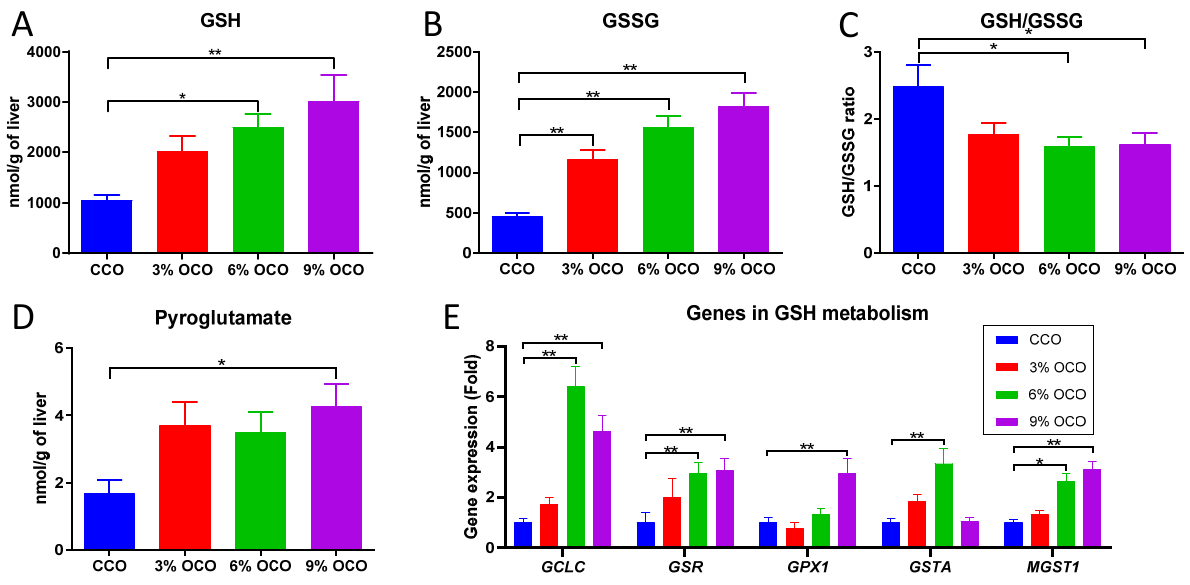
Figure 5. Effects of dietary concentrations of oxidized corn oil (OCO) on the concentrations of metabolites and the levels of gene expression in hepatic glutathione metabolism. ( A ) GSH. ( B ) GSSG. ( C ) GSH/GSSG ratio. ( D ) Pyroglutamate. ( E ) Gene expression level of the enzymes in GSH metabolism. The average expression level of genes in control corn oil (CCO) treatment of pig liver samples was artificially set as 1. Value = mean ± SEM (n = 8 pigs/group). * p < 0.05 and ** p < 0.01 from one-way ANOVA followed by the Tukey post hoc test between CCO and OCO treatments.